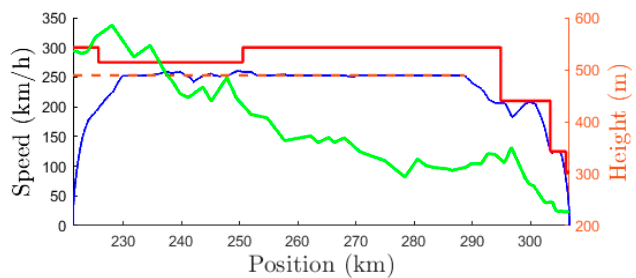
Figure 8. Eco-driving speed profile for the commercial time in the Calatayud–Zaragoza section.